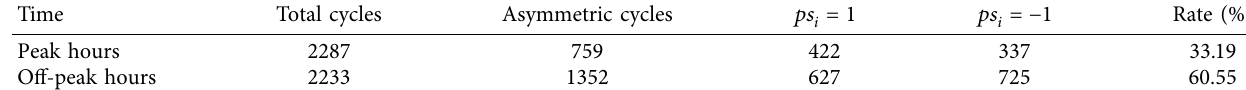
Table 1: Distribution of asymmetric traffic flow ( ac